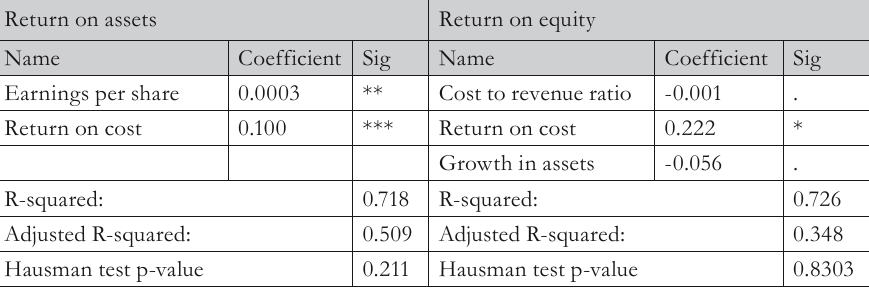
Tab. 5 - Construction sector: significant variables predicting ROA and ROE. Source: